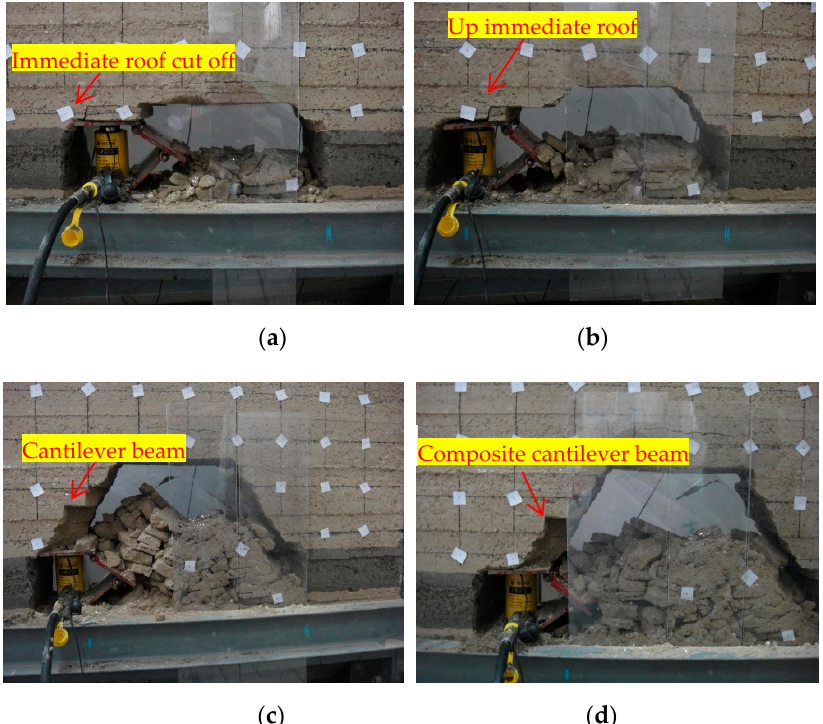
Figure 5. Cantilever beam structure for first weighting of large mining height roof: ( a ) immediate roof cut off in front of support, ( b ) up immediate roof, ( c ) cantilever beam, ( d ) composite cantilever beam structure.